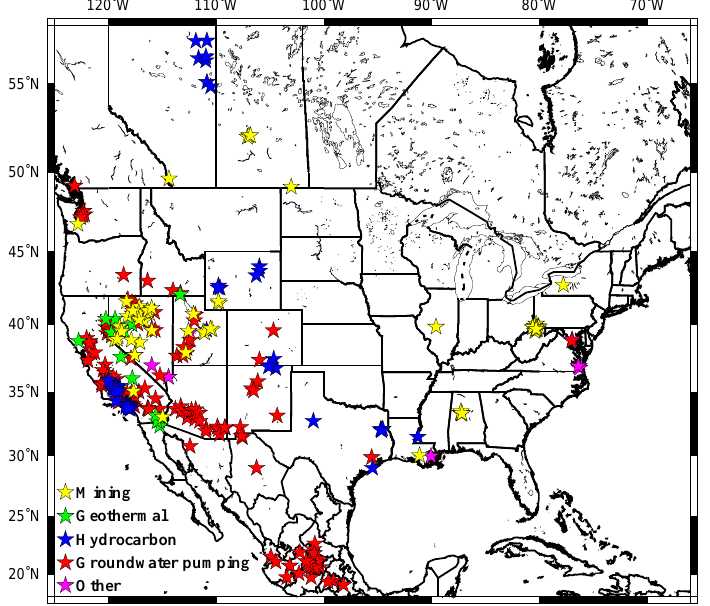
Figure 4. An incomplete compilation of 263 areas of ground deformation caused by human activities in North America from various sources as detected by satellite InSAR (see Table S1)—see text for details on how potential source of deformation was identified. An additional four sites in Idaho were documented by Greene [37], but are not plotted as coordinates of the mines are not